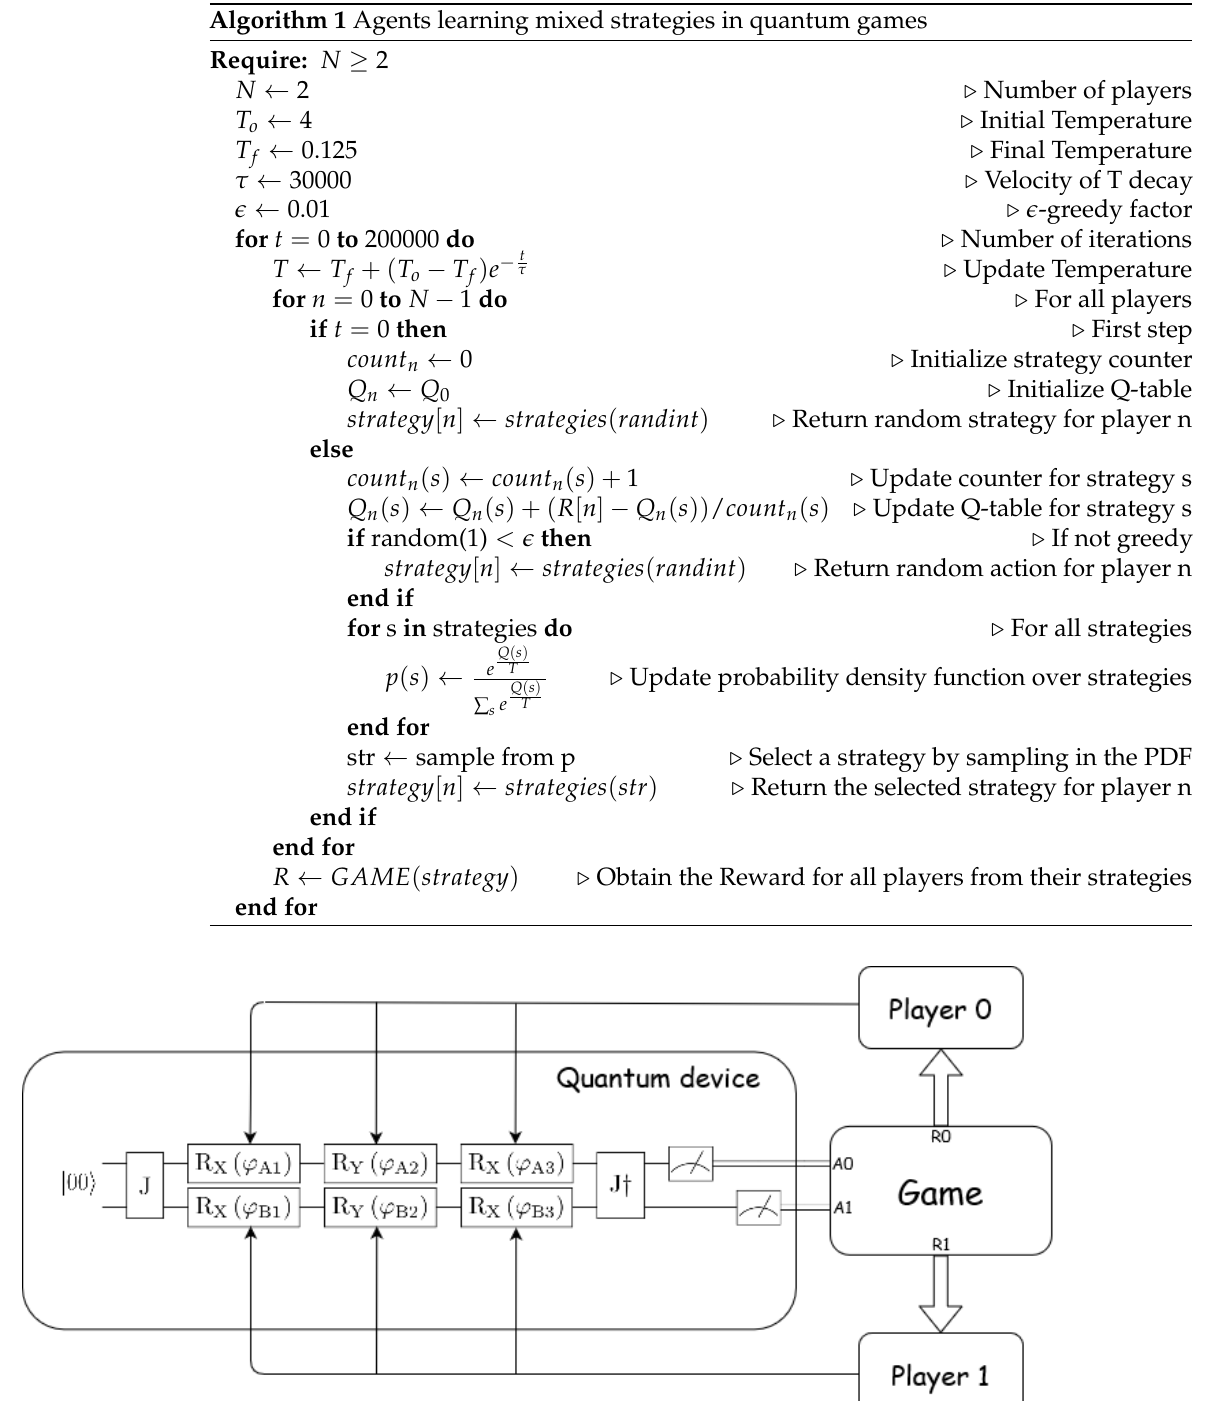
Figure 3. Model of two players learning mixed strategies using parameterized quantum